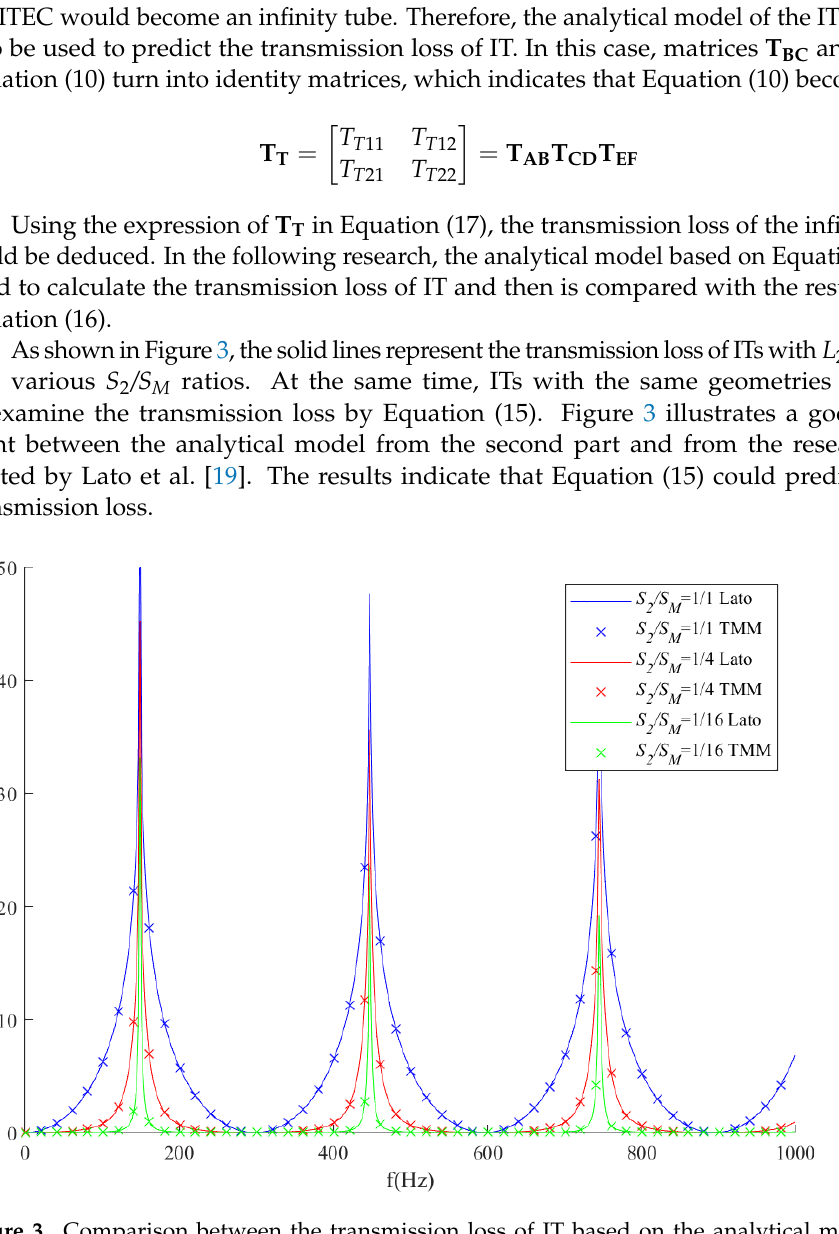
Figure 3. Comparison between the transmission loss of IT based on the analytical model from Section 2 and Equation (16); the solid lines are transmission loss results extracted from Lato et al. [19], and the dotted crosses are calculated by TMM from Section 2.